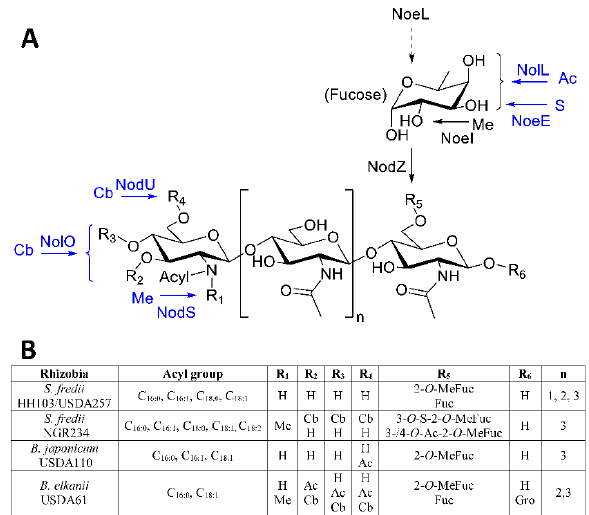
Figure 1. ( A ) Structure of nodulation factors produced by Sinorhizobium fredii HH103, USDA257, and NGR234 and Nod proteins involved in their decoration. Proteins marked in blue are only found in strain NGR234. Abbreviations of substituents are as follows: Ac, acetyl; Cb, carbamoyl; Me, methyl; S, sulfate; and ( B ) Comparison of Nod factors produced by different S. fredii strains, Bradyrhizobium japonicum USDA110, and Bradyrhizobium elkanii USDA61.